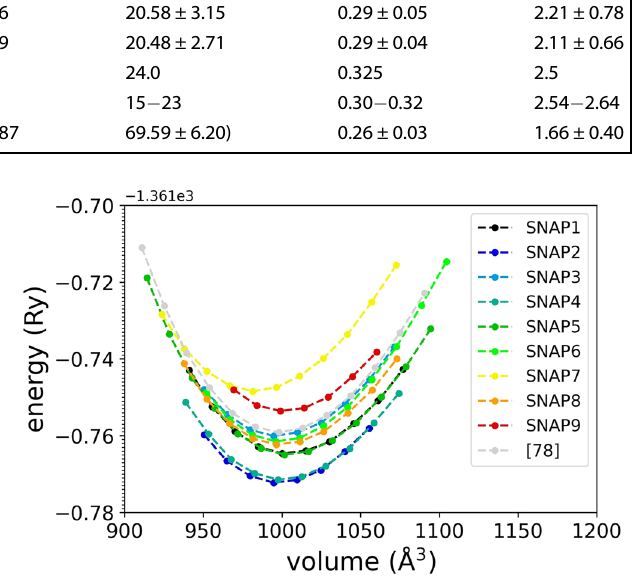
Fig. 7 Energy-volume relations (and fi t to the Murnaghan equation of state, Equation (15)) from isotropic compression and expansion of nine fully relaxed snapshots from the 600 K- NPT CP molecular dynamics of t-LGPS, and of the global minimum energy structure reported in ref. 78 , previously fully relaxed. At each volume the energy is calculated by relaxing the atoms (see main